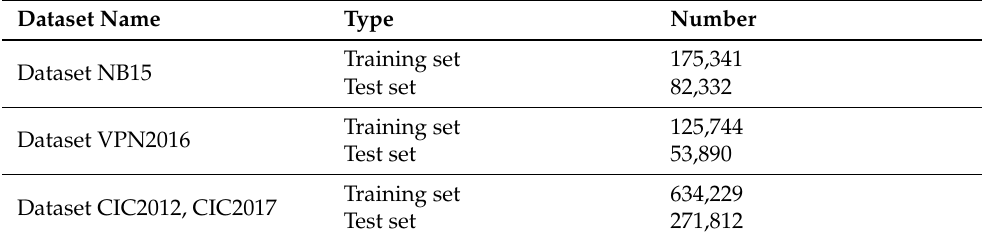
Table 3. Samples number of training set and test